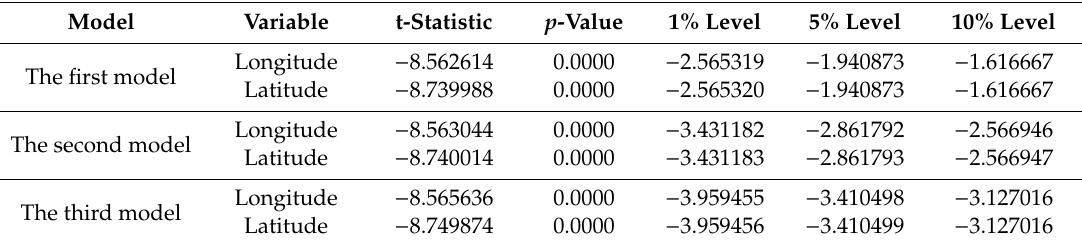
Table 3. The ADF test results of the one-order longitude and latitude di ff erences of the one-order di ff erence taxi